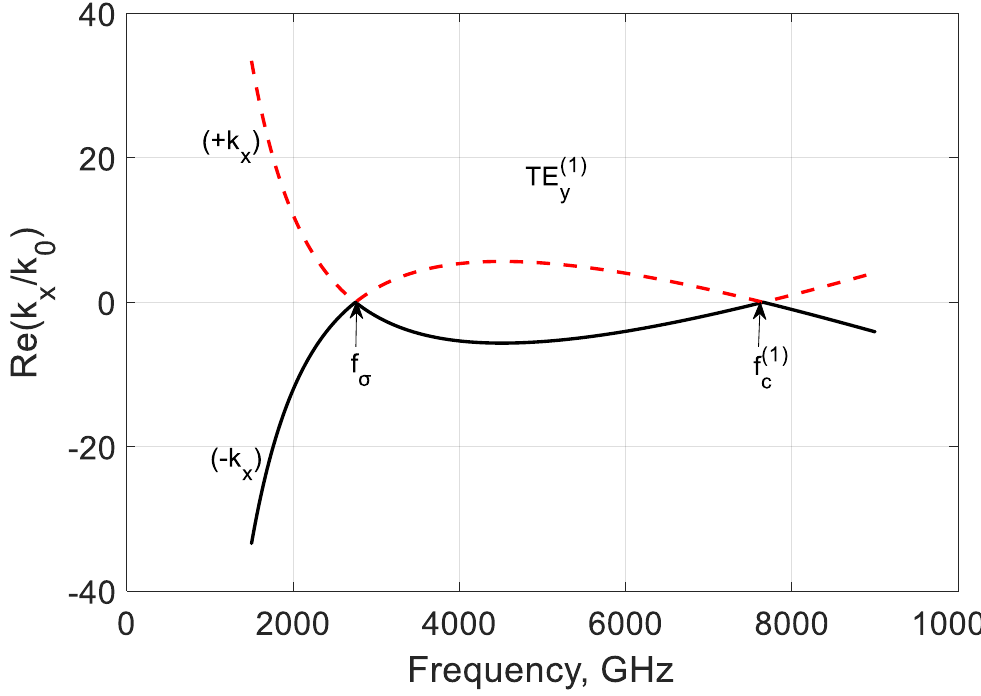
( 1 ) Figure 7. Normalized real parts of ∓ k x / k 0 of the TE TE backward mode of a graphene H-waveguide k k of the   1 Figure 7. Normalized real parts of y backward mode of a graphene H-waveguide of y 0 x the height b = 0.01 mm and width 2 a = ∞ , ε r = 3.84, and µ r = 1. Parameters used for calculation of   , and 1.   Parameters used for of the height 0.01 mm b  and width 2 a   , 3.84 r r σ τ = 1 g are from Ref. [21]: T = 300 K, E F = 40 meV, and  are from Ref. [21]: 1 ps.  calculation of g